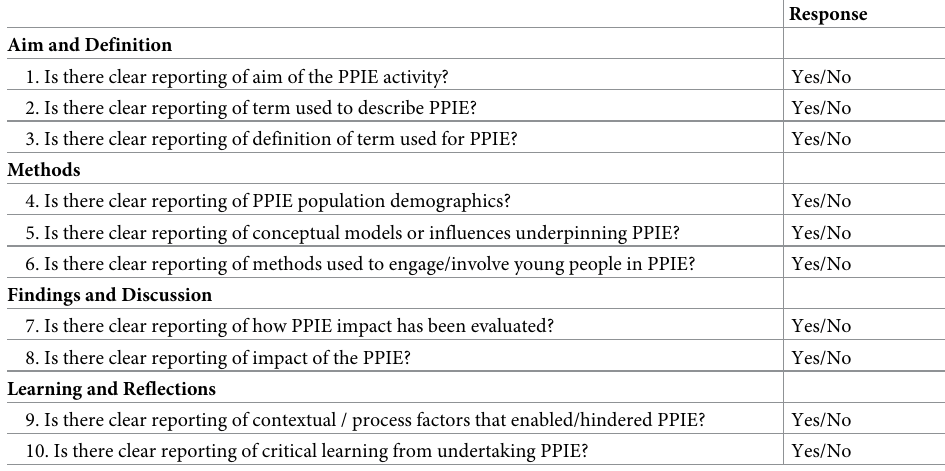
Table 3. QRIPPAT (Quality of Reporting Involvement and Engagement of Patients and the Public Appraisal